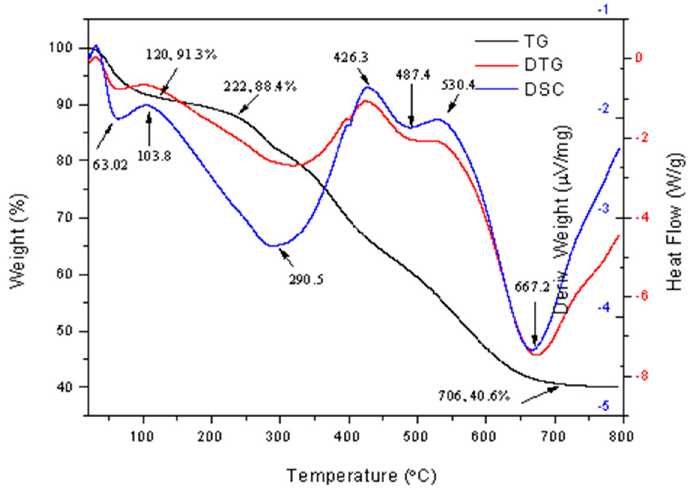
Figure 7. The TG-DSC curves of the ZPS–PVPA–SO 3 H.